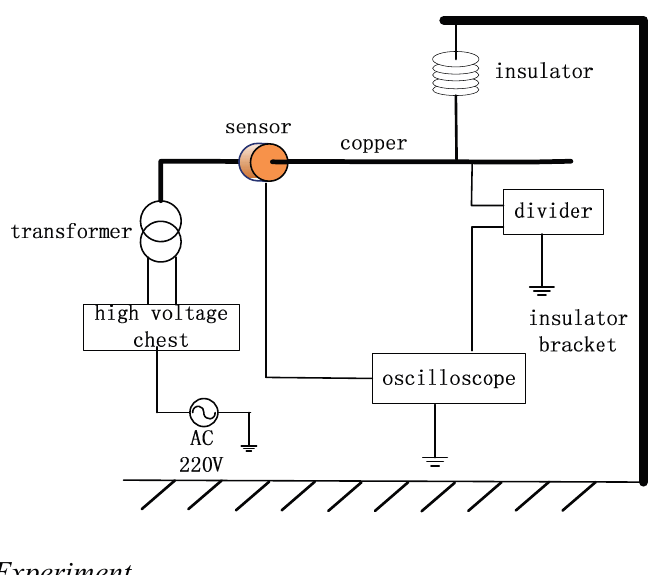
Figure 10. Test platform of high